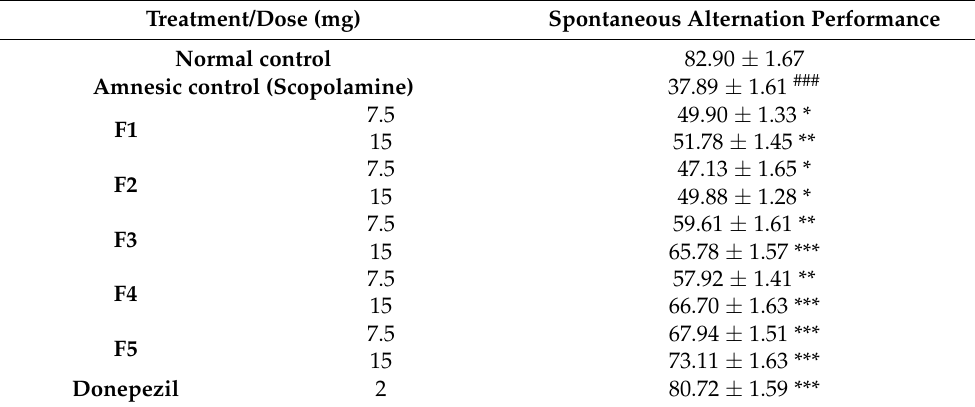
Table 5. Effect on % Spontaneous alternation performance of F1 – F5 in behavioral Y-maze test. Treatment/Dose (mg) Spontaneous Alternation Performance Normal control 82.90 ± 1.67 Amnesic control (Scopolamine) 37.89 ± 1.61 ### 7.5 49.90 ± 1.33 * F1 51.78 ± 1.45